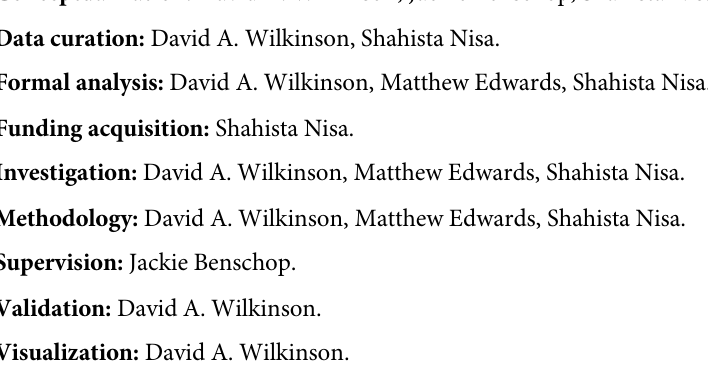
S1 Table. Bacterial strains used for metabarcoding controls. S2 Table. Primers analysed or used in this